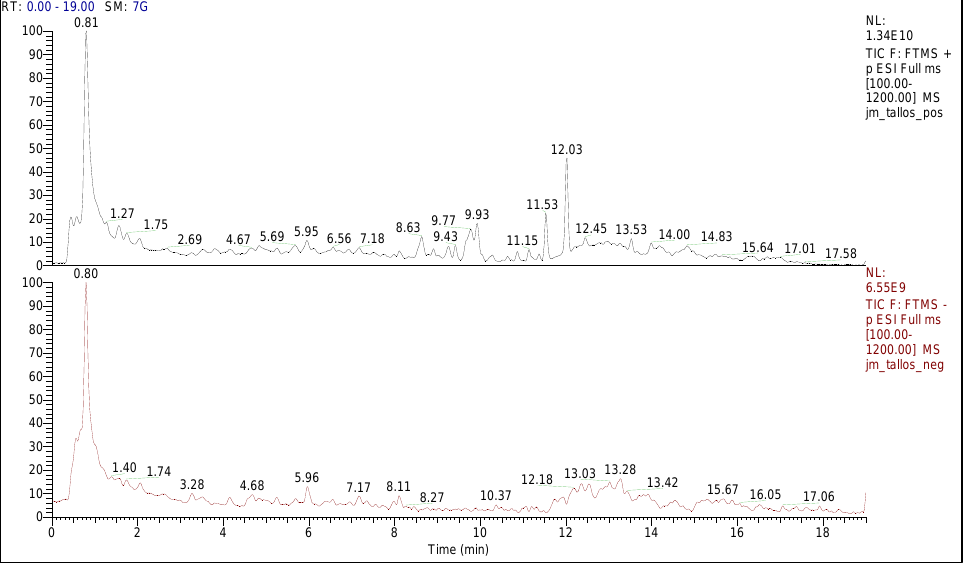
Figure 2. Chromatographic profile (LC-ESI-MS/MS) of stems of J. macrantha ethyl acetate fraction, in both ESI (+) and ESI ( − ) ionization modes. Table 2. Phytochemical constituents of leaves of J. macrantha ethyl acetate fraction determined by LC-ESI-MS/MS.